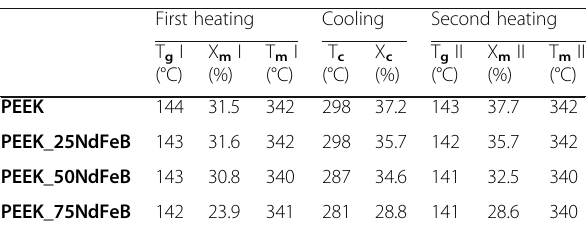
Table 3 Summary of the main results of DSC analysis